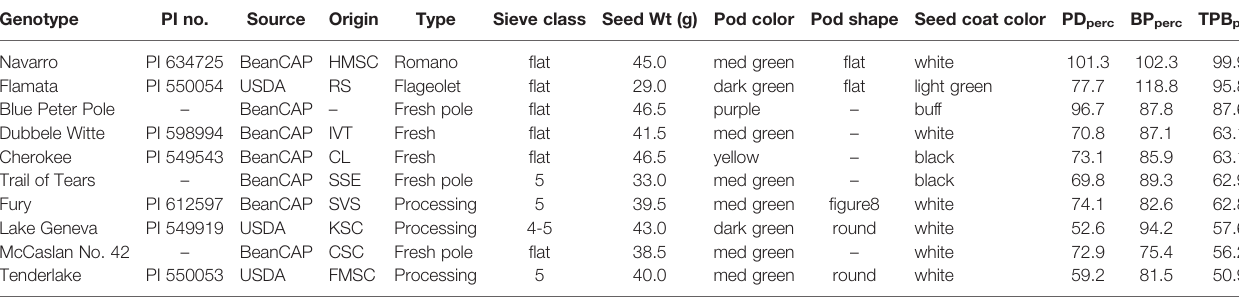
TABLE 2 | List of snap bean genotypes in the SNAP diversity panel most tolerant to sulfentrazone. Genotype PI no.